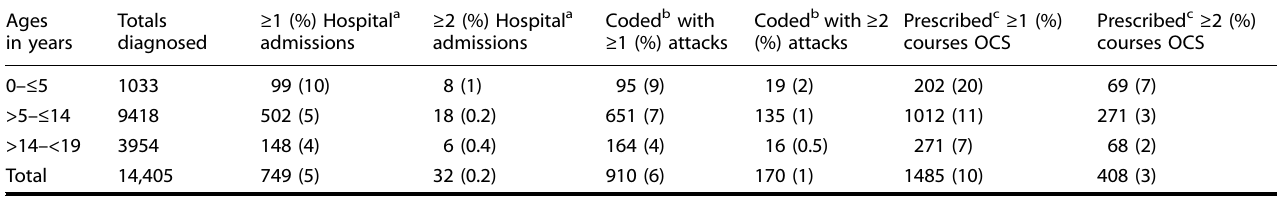
Table 2. Age distribution of children and young people (CYP) diagnosed with asthma who had asthma exacerbations during 12 months (from April